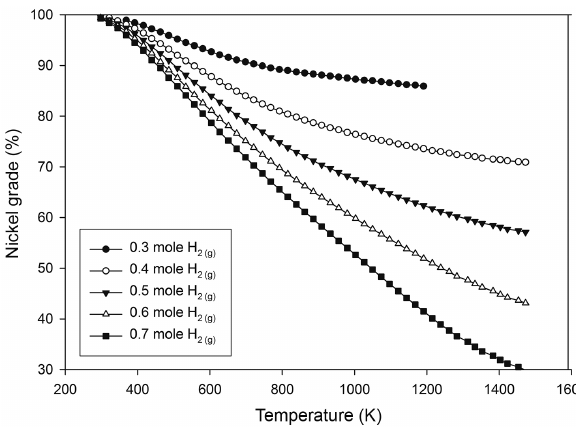
Figure 8: Effect of temperature on the nickel grade of the ferronickel for reduction of the calcined ore for various amounts of hydrogen per 100 kg of ore.